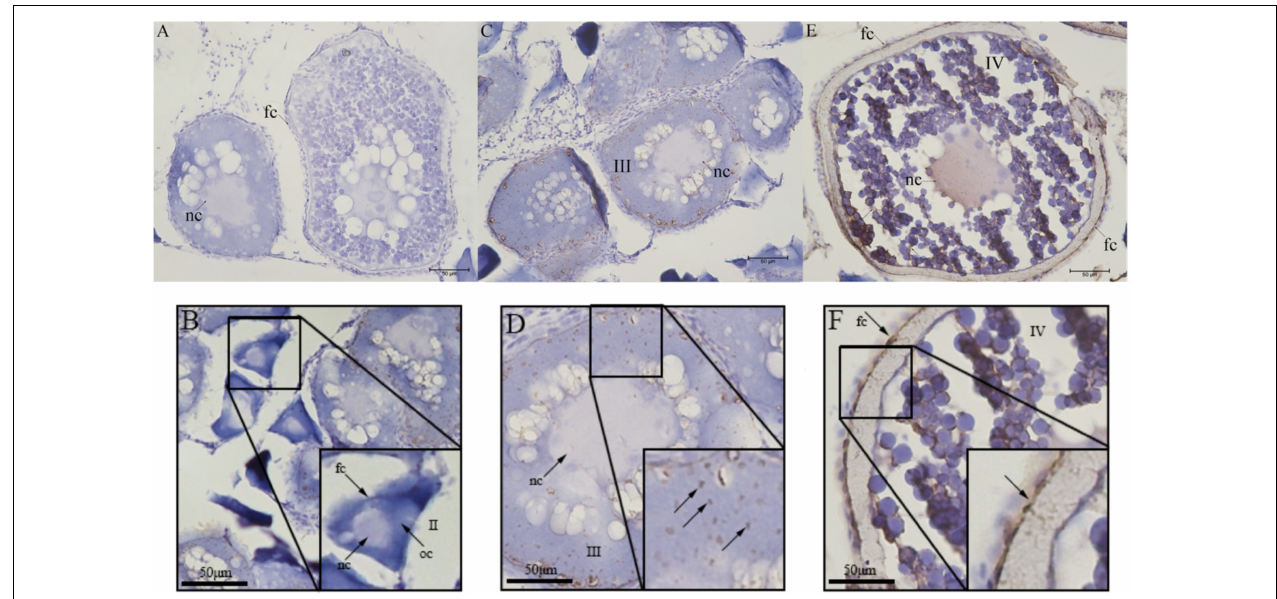
FIGURE 4 | Immunohistochemical localization of UI protein in ovarian tissue of Japanese flounder. The serial sections of the ovaries were immunostained with anti-flounder UI. (A) Negative control, (B) Stage II follicles, (C,D) Stage III follicles, and (E,F) Stage IV follicles. Scale bars: 50 µ m. Black arrows with/without letters represent specific locations or positive signal, respectively. Stage II 90 ∼ 300 µ m, stage III 300 ∼ 500 µ m, and stage IV 500 ∼ 800 µ m. oc, oocyte; fc, follicular cells; nc, nucleus.